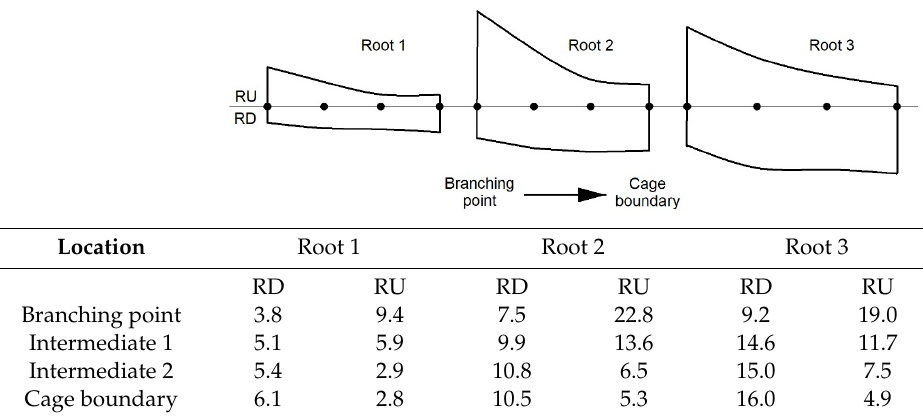
Location Root 1 Location Root 1 Root 2 Root 3 RD RU